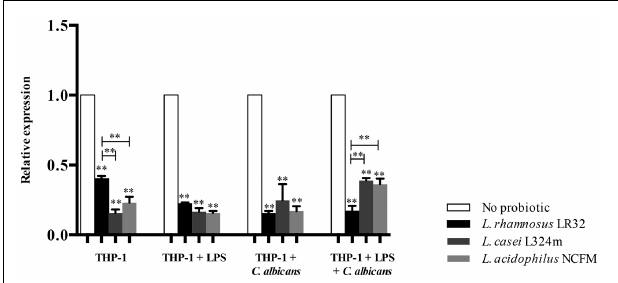
FIGURE 4 | Relative transcription of CLEC7A in macrophages pretreated with probiotics alone or with both LPS and probiotics for 12 h before being challenged with C. albicans or LPS for 3 h. L. rhamnosus LR32, L. casei L324m, and L. acidophilus NCFM were tested in these different situations. The transcription of CLEC7A was normalized to GAPDH reference gene (internal control). Groups with no probiotic bacteria pretreatment were set at 1. Data are presented as mean ± SD. ∗∗ p <